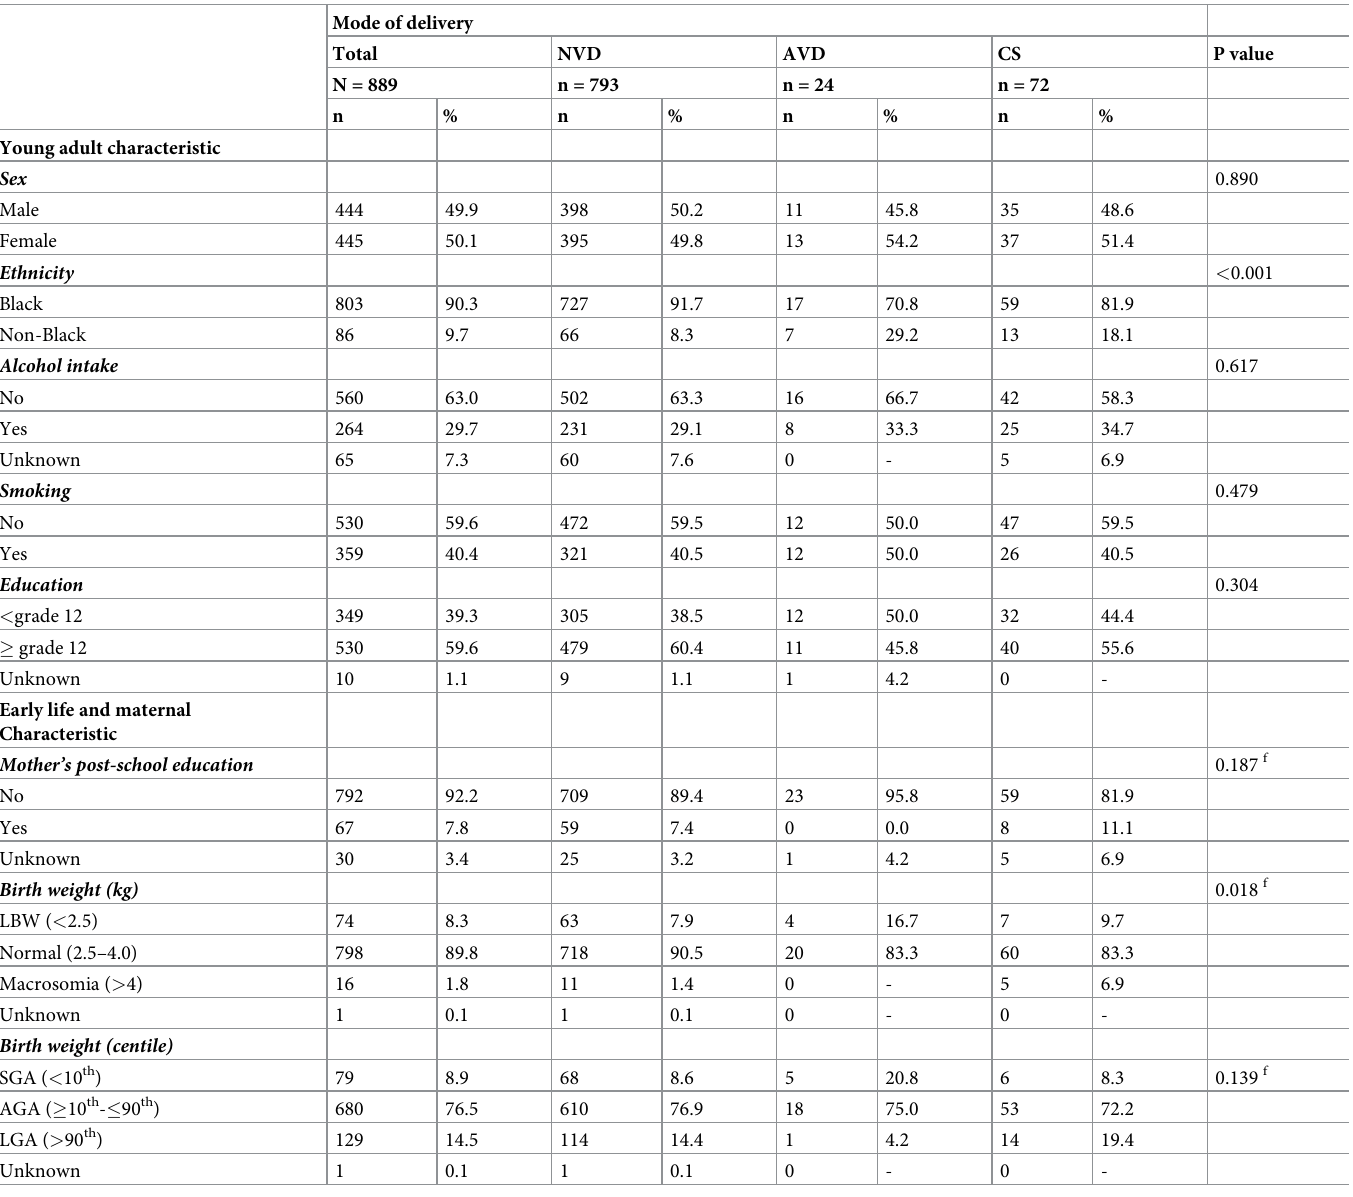
Table 3. Socio-demographic characteristics by mode of